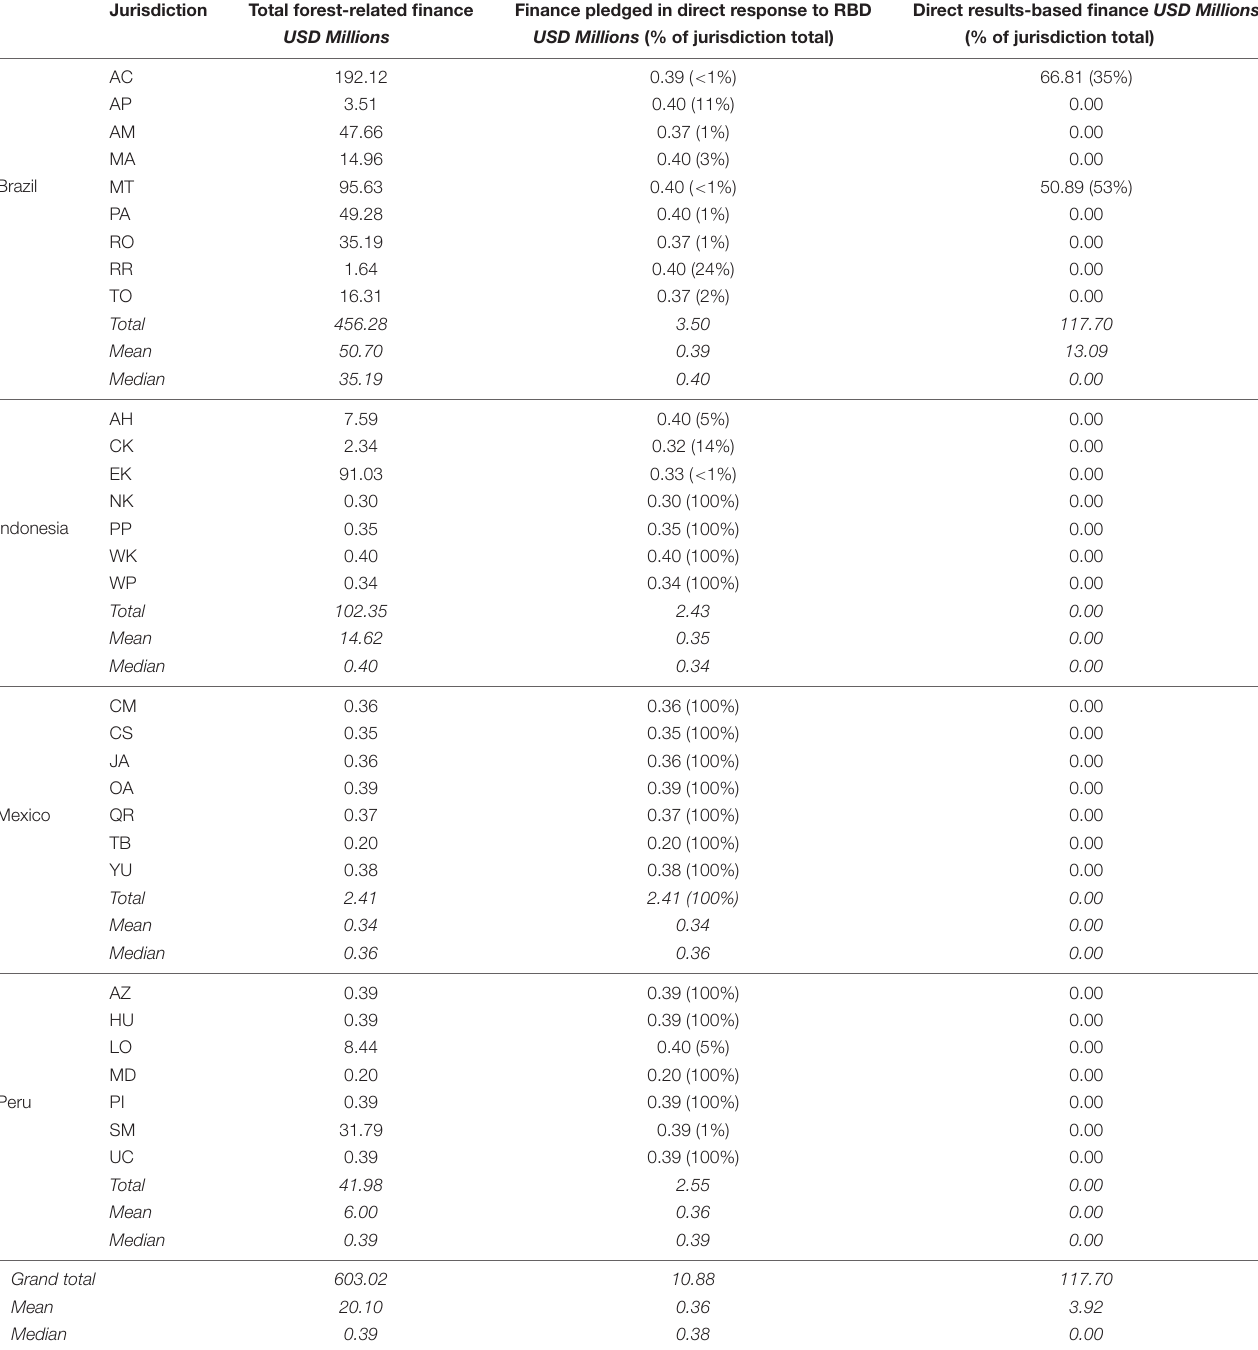
TABLE 8 | Total forest finance pledged to study jurisdictions from 2010 to 2019, segregated by the amounts pledged in direct response to RBD and as direct results-based